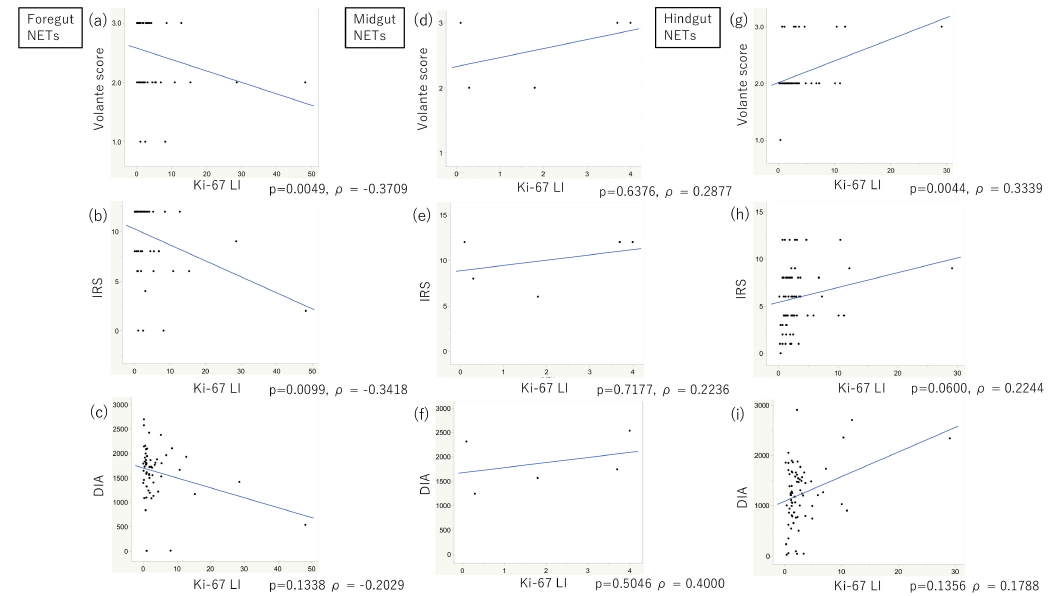
Figure 3. Correlation between SSTR2 immunoreactivity and Ki-67 labeling index (LI). ( a – c ) In the foregut NETs, SSTR2 was significantly inversely correlated with Ki-67 LI, especially when using the Volante scores and IRSs ( p = 0.0049, ρ = − 0.3709 and p = 0.0099, ρ = − 0.3418, respectively). ( d – f ) In the midgut NETs, SSTR2 was positively correlated with Ki-67 LI, although not significantly. ( g – i ) In the hindgut NETs, SSTR2 was positively correlated with Ki-67 LI, especially when evaluated using the Volante scores and IRSs; the former correlation was significant ( p = 0.0044, ρ = 0.3339 and p = 0.0600, ρ = 0.2244,